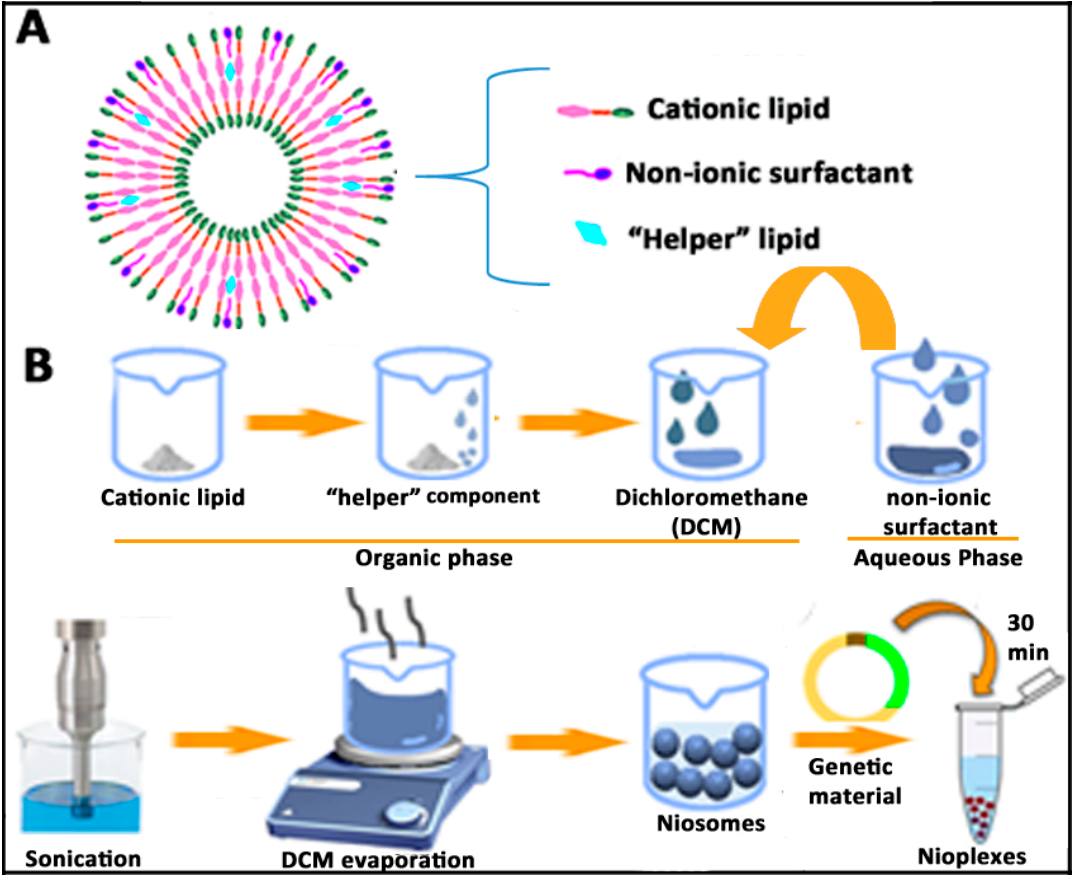
Figure 3. ( A ) Bilayer structure of niosomes and disposition of components. ( B ) Schematic representation of the solvent evaporation method for the elaboration of niosomes and corresponding nioplexes.